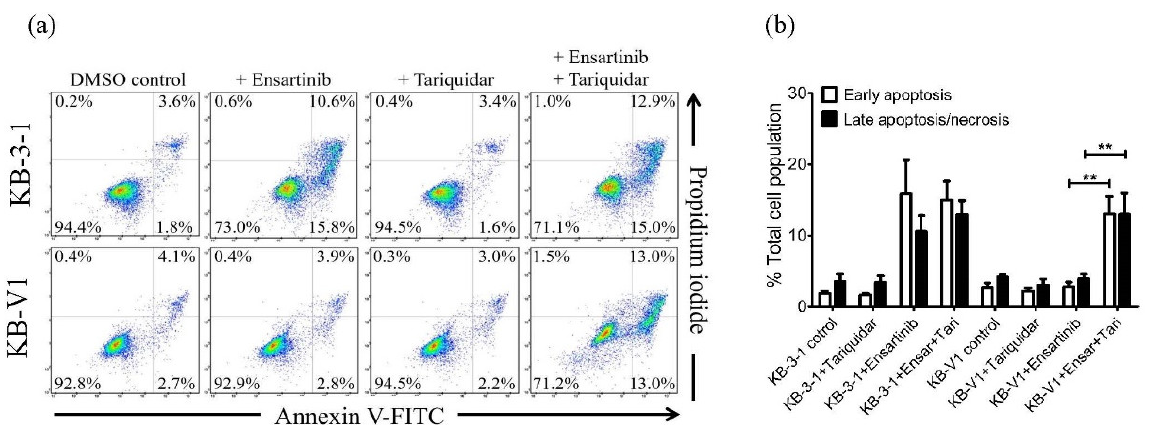
Figure 4. Ensartinib induces apoptosis in cancer cell lines. ( a ) Representative dot plots of the extent of apoptosis determined in KB-3-1 cells (upper panels) and the P-gp-overexpressing subline KB-V1 (lower panels) treated with DMSO (DMSO control), 2 µ M ensartinib (+ Ensartinib), 1 µ M tariquidar (+ Tariquidar), or a combination of 2 µ M ensartinib and 1 µ M tariquidar (+ Ensartinib + Tariquidar) for 48 h. Cells were processed and analyzed as described in Materials and Methods and as described previously [40]. ( b ) Quantitative data are presented as mean values ± S.D. obtained from at least three independent experiments. ** p < 0.01, versus the same treatment in the presence of tariquidar.